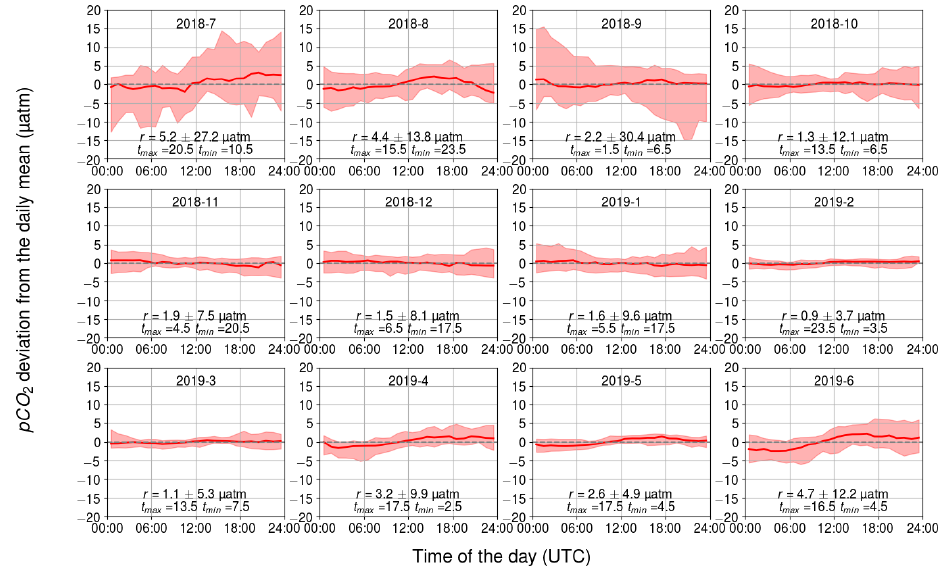
Figure 7. Temperature-induced cumulative daily changes in p CO 2 , shown as the monthly climatological median and the difference of the minimum of the 10th percentile and the maximum of the 90th percentile. The y axis shows the p CO 2 deviation (in µatm) and the x axis shows the hour of the day. Range, r , and the time for the maximum and minimum p CO 2 are also given.